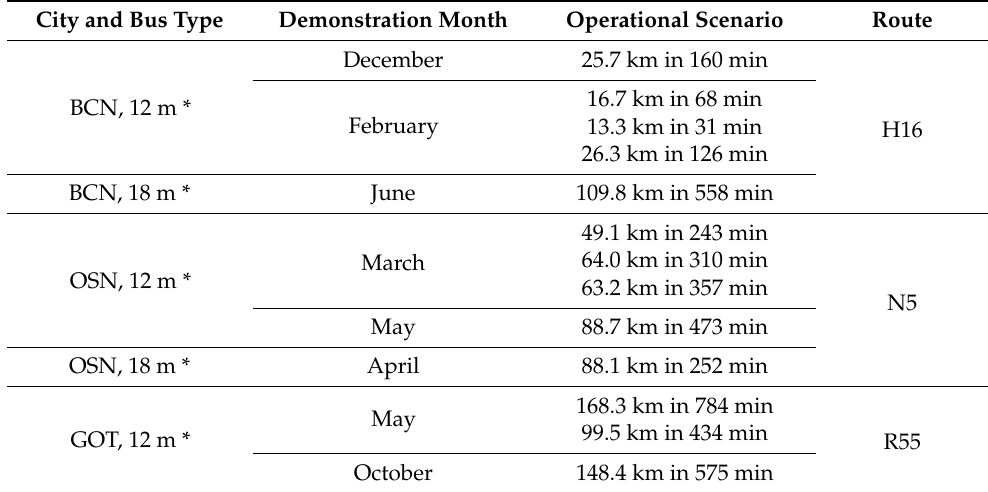
Table 2. Overview of the demonstration scenarios.